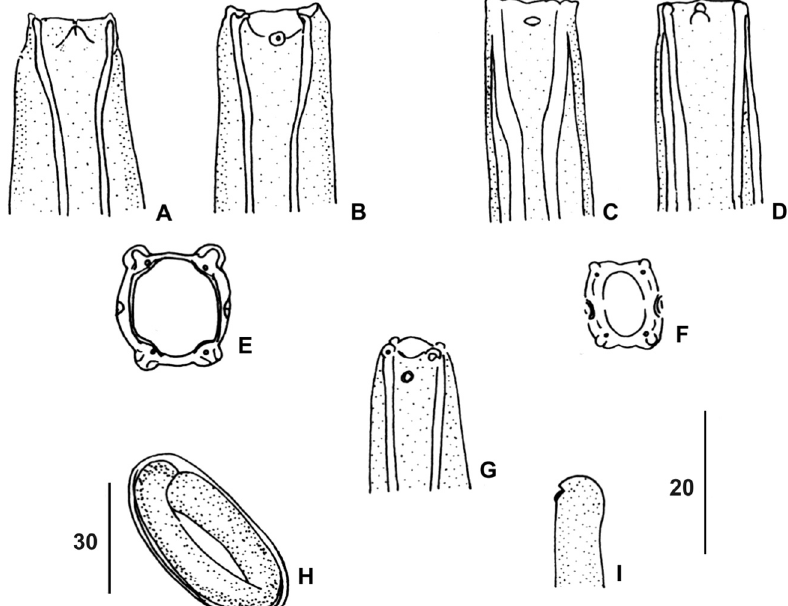
Figure 2. Anterior extremities of Trichospirura spp. A , B , T. aethiopica n. sp., female, submedian and lateral view, respectively. C , D , T. leptostoma , lateral and submedian view, respectively. E , F , en face view of T. aethiopica n. sp. (E) and T. leptostoma (F) . G, T. amphibiophila , lateral view. H , I , T. aethiopica n. sp. H , larvated egg. I , cephalic extremity of first-stage larva, dorsal view. Scales in l